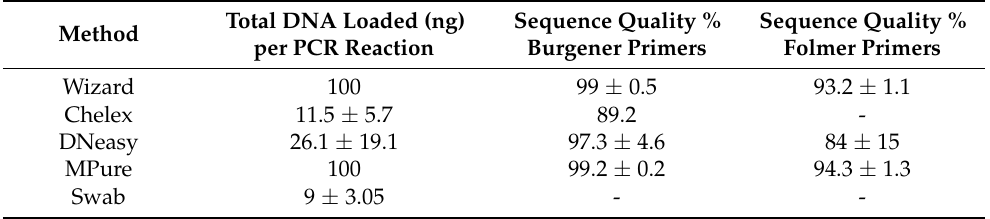
Table 3. Sequence quality percentage of the tested DNA extraction methods. Data are presented as Mean ± standard deviations of samples per